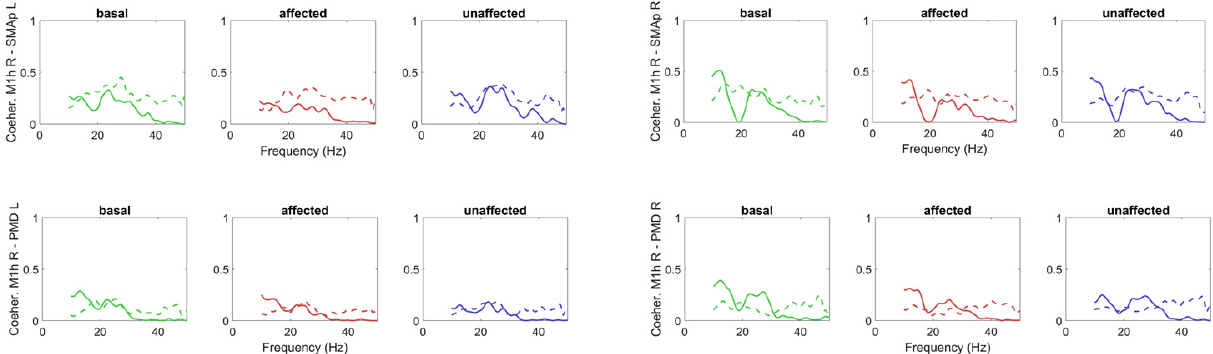
Figure 9. Coherences among the M1h R and all other ROIs obtained in basal conditions (green lines) and during movement of the affected (red lines) and unaffected (blue lines) hands. The continuous lines represent model simulation results with optimal parameter values, and the dashed lines the values computed from the experimental data. It is worth noting that